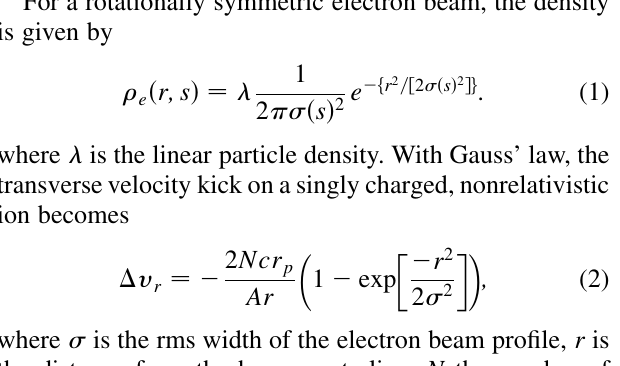
FIG. 1. Impulse transmitted on an ion from a passing beam electron